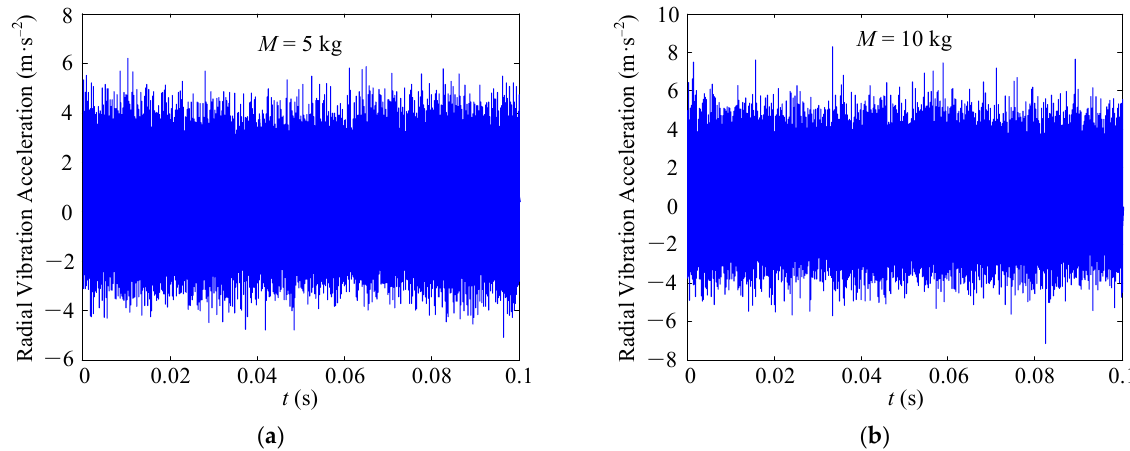
Figure 5. Radial vibration acceleration response of DGB 6205 under different radial loads: ( a ) radial vibration acceleration under 5 kg weight and ( b ) radial vibration acceleration under 10 kg weight.